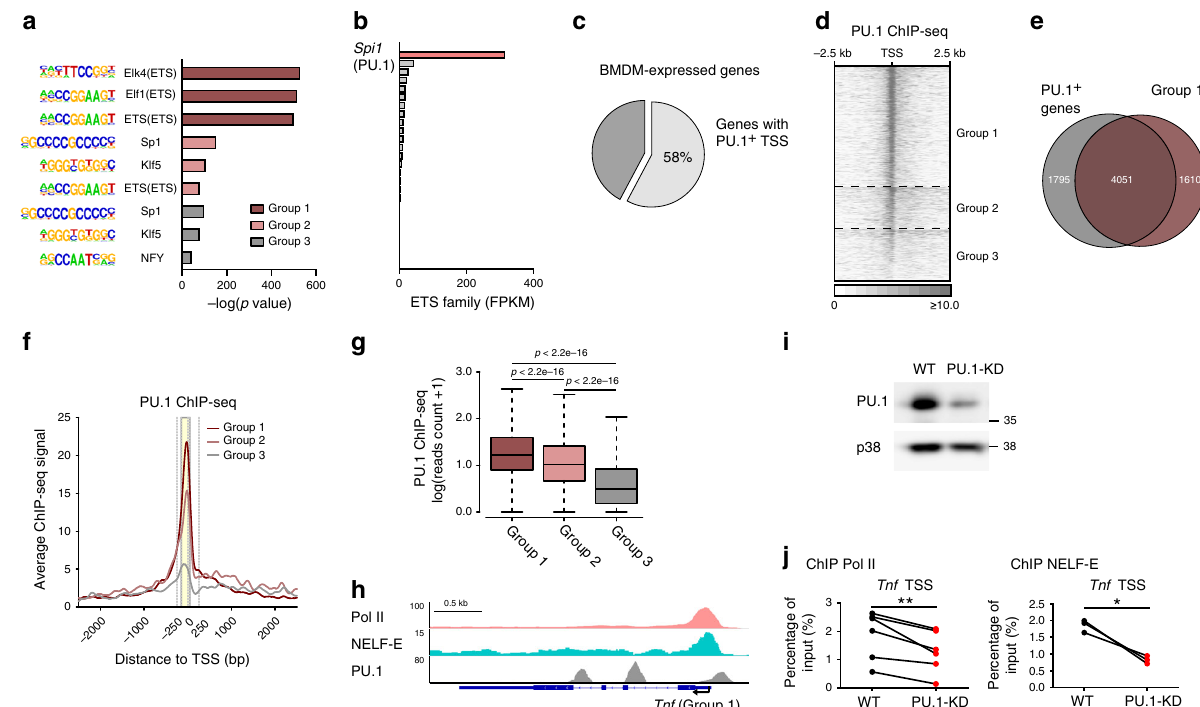
Fig. 2 PU.1 contributes to establishment of promoter – proximal pausing in macrophages. a Motif enrichment analysis in TSS regions of BMDM- expressed genes. Top three most enriched transcription factor binding motifs in TSS region of each gene group are shown; x -axis is − log 10 ( p value) for each enriched motif. Binomial distribution was used for p value calculation, and no adjustments were made for multiple comparisons. b Expression level (fragments per kilobase of transcript per million mapped reads [FPKM]) measured by RNA-seq in resting BMDM for each of the 26 mouse ETS family transcription factors. c The percentage of genes with PU.1 + TSS regions (PU.1 + genes) in BMDM-expressed genes. d Heat map of PU.1 ChIP-seq signals in resting BMDM around the TSS regions for BMDM-expressed genes. For each group, the rows were sorted as in Fig. 1a. e The overlap between PU.1 + BMDM-expressed genes and group 1 genes. f Average signals of PU.1 ChIP-seq in resting BMDM around TSS regions of group 1 – 3 genes, as indicated. g PU.1 ChIP-seq reads quanti fi ed in resting BMDM in − 150 to + 50 bp region (boxed in ( f )) are shown as boxplots for group 1 – 3 genes, as indicated. The boxes and bars express data as in Fig. 1j. p Values (group 1/group 2 P < 2.2e − 16 , group 1/group 3 P < 2.2e − 16 , group 2/group 3 P < 2.2e − 16 ) were calculated by two sided Mann – Whitney U test. h Tracks of Pol II, NELF-E, and PU.1 ChIP-seq in resting BMDM are shown for Tnf , a representative group 1 gene. i Western blot for PU.1 and p38 (loading control) in WT and PU.1-KD iBMDM. Shown is one representative blot from three biological replicates. j The